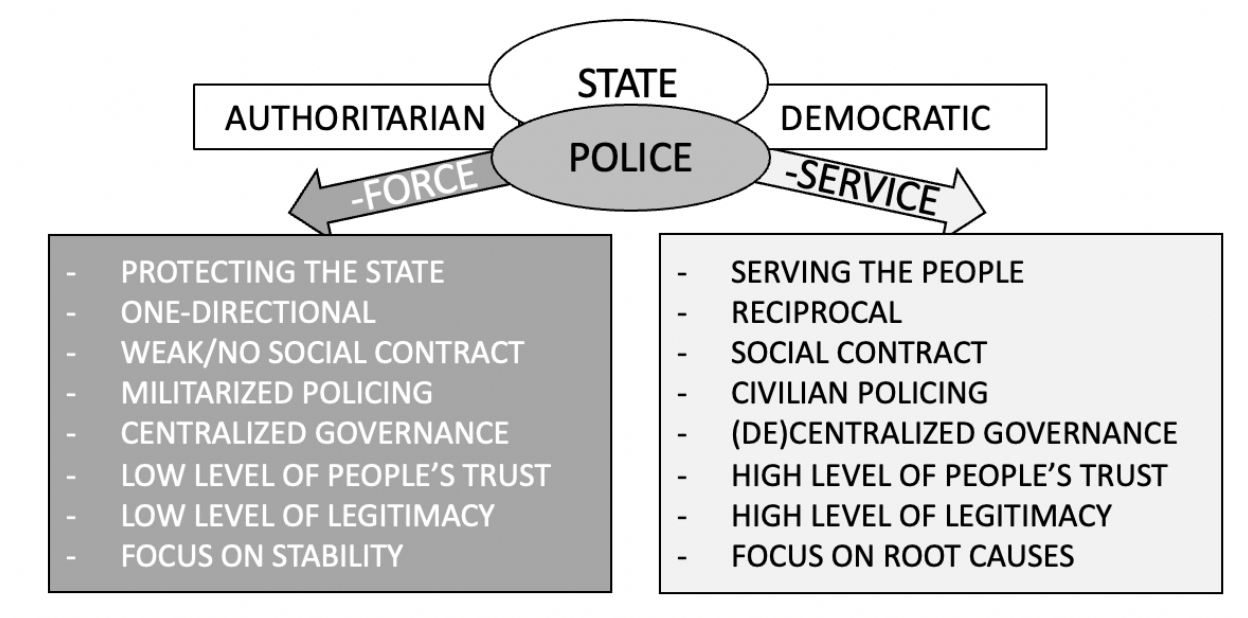
Figure 1. Ideal typical policing